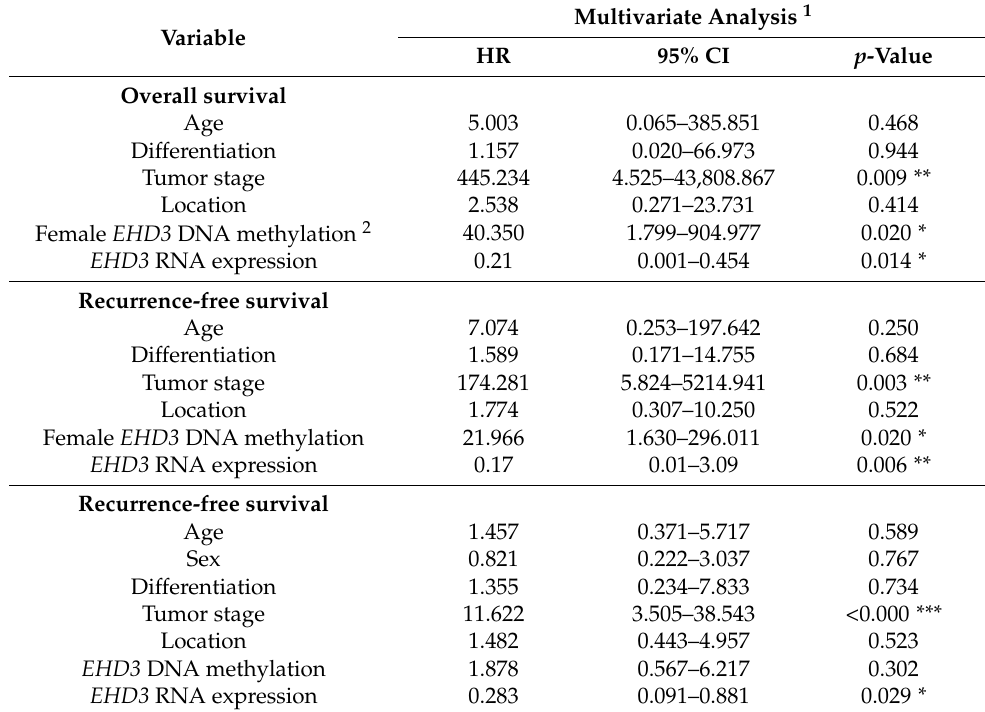
Table 2. Cox proportional-hazards survival analysis in Taiwanese patients with